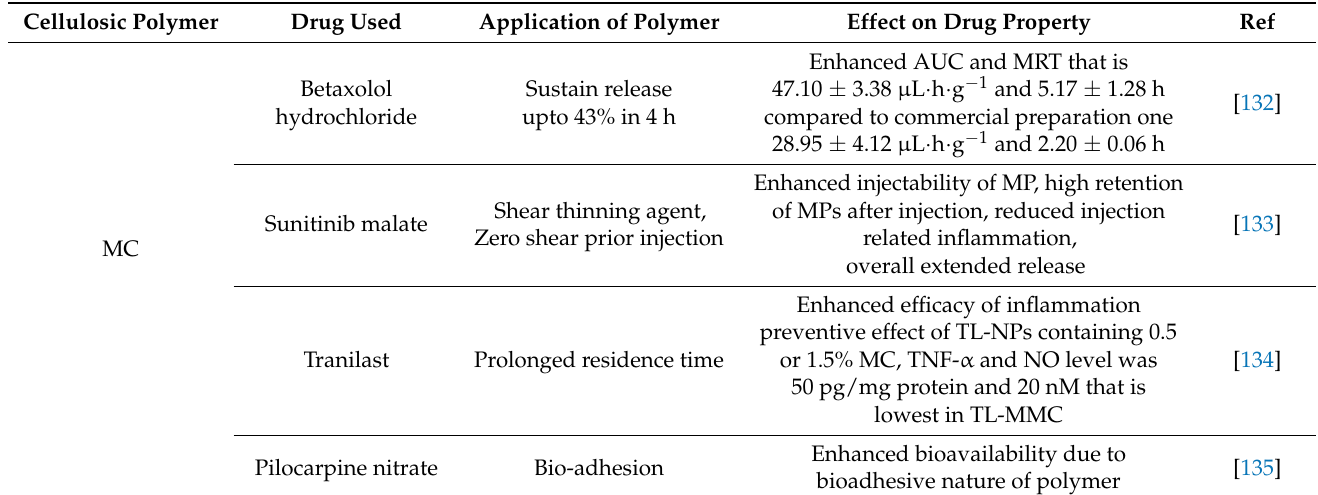
Table 2. Application of MC in ocular drug